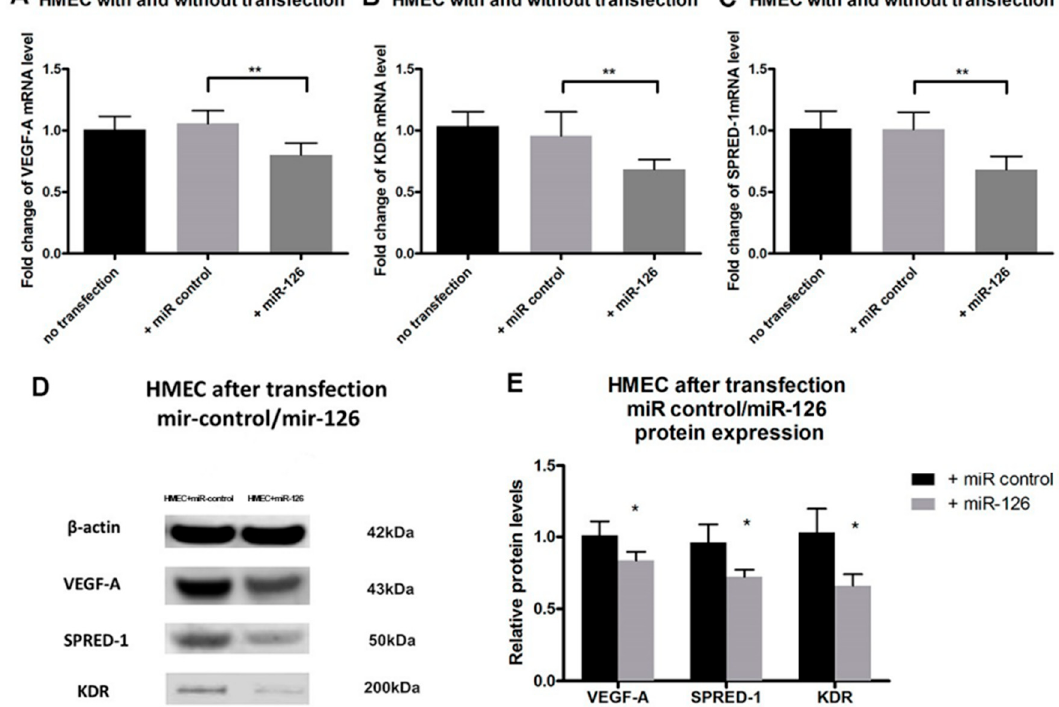
Figure 5. miR-126 target genes expression in HMEC after transfection: ( A ) VEGF-A ; ( B ) KDR ; and ( C ) SPRED-1 mRNA expression in HMECs was determined by qPCR in the following treatment groups: No transfection: HMECs without transfection; + miR-control : HMECs transfected with miR-control ; + miR-126 : HMECs transfected with miR-126 mimic . Data are presented as mean fold change of mRNA levels ± SD ( n = 4), ** p < 0.01; ( D ) Western blot images of miR-126 target genes protein in HMEC after transfection of either the negative control miR-126 ; and ( E ) Quantification of relative target genes protein expression in HMECs receiving miR-control or miR-126 transfection determined by Western blot. Data are presented as mean fold change of protein levels ± SD ( n = 4), * p < 0.05.